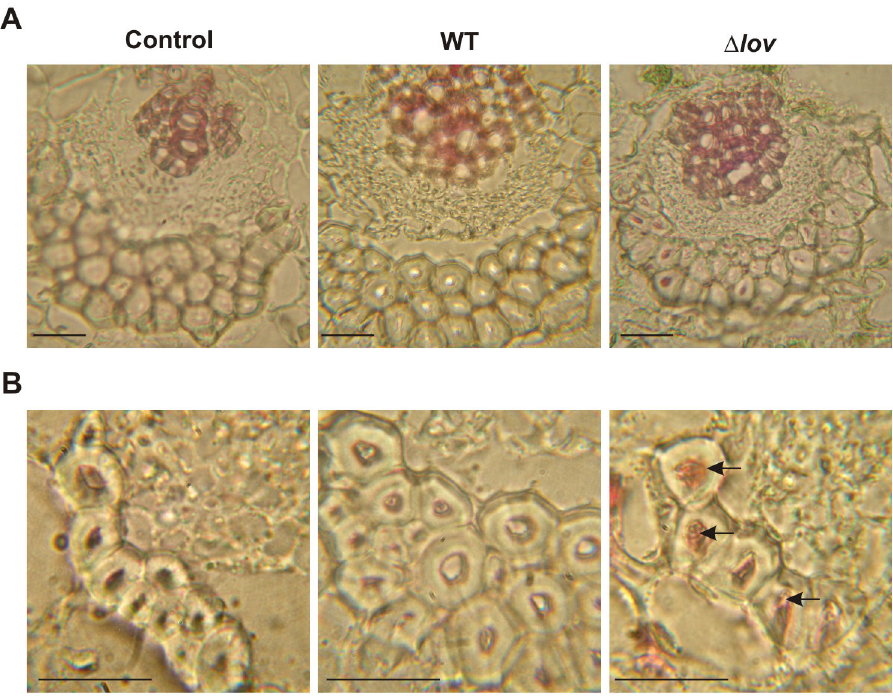
Figure 4. Histological analysis of lignin deposition in orange leaves upon interaction with Xanthomonas citri subsp. citri. Lignin deposition was analysed by acid fluoroglucin staining of orange leaves inoculated with WT and Δ lov X. citri subsp. citri strains and control treatments (10 mM MgCl ). Stained tissues were observed with a visible microscope at 7 days post inoculation 2 (dpi) using a 1000X magnification. The wine-red coloration represents lignin deposition in plant secondary cell walls. 3A panels show infected tissues sections in which xylem vessels as well as phloem and sclerenchymatous fibers surrounding the vascular bundles are visualized. 3B panels show zoomed-in images of sclerenchymatous fibers where internal lignin content is indicated with arrows. Scale bars: 5 µm. Identical results were obtained with three independent biological